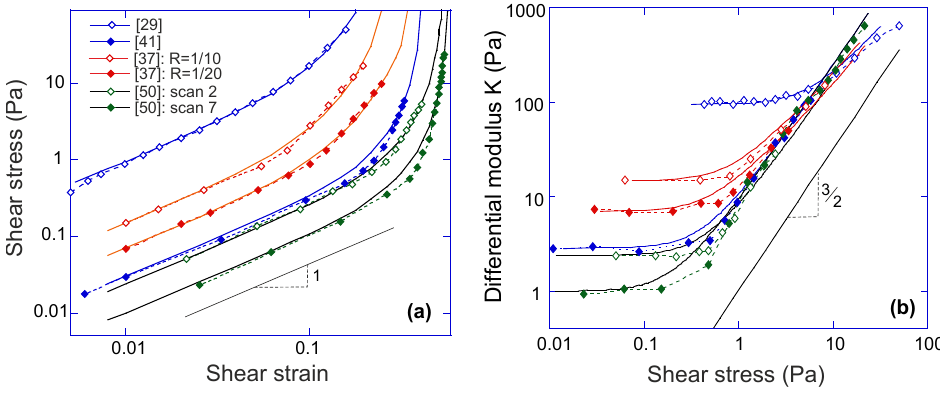
Figure 9. ( a ) Fitting stress-strain experimental data of different actin networks under simple shear (the source references labelled in the plot). The log-log plot nature highlights the linear-elasticity regime with the modulus G 0 , before the stiffening sets in at higher shear; ( b ) The stress-stiffening of actin networks represented by the K ∼ σ 3/2 scaling relation. All data sets are the same as labelled in the plot (a), and solid lines are theoretical curves using the same fitted